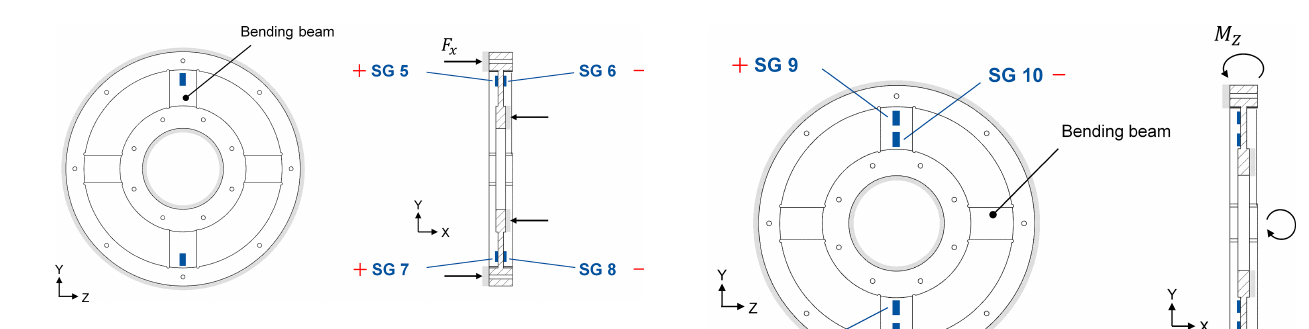
Figure 5. Design principle of the axial force element.